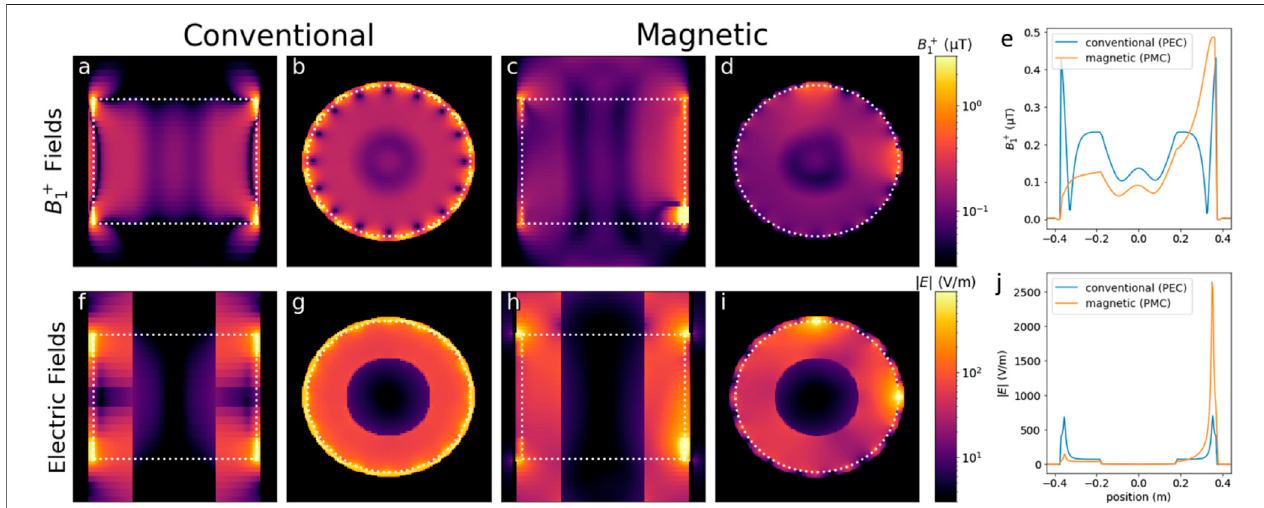
FIGURE 7 | Loaded birdcage coil fi eld distributions with the conventional [PEC, (A,B,F,G) ] or magnetic [PMC, (C,D,H,I) ] shield. (A – D) B 1+ fi eld distributions. (F – I) electric fi elddistributions. (A,C,F,H) Sagittalslices. (B,D,G,I) transverseslices.FortheB 1+ distributions,boththesagittalandtransverseslicesarepositionedattheorigin (x (cid:1) 0 or y (cid:1) 0). The transverse slices of the electric fi elds are positioned at z (cid:1) 200 mm (see Figure 6A ). The white dashed line denotes the birdcage outline. (E,J) transverse pro fi les of B 1 and electric fi elds, respectively, at the same height as the transverse slices. All results are normalized to 1 W of accepted power.